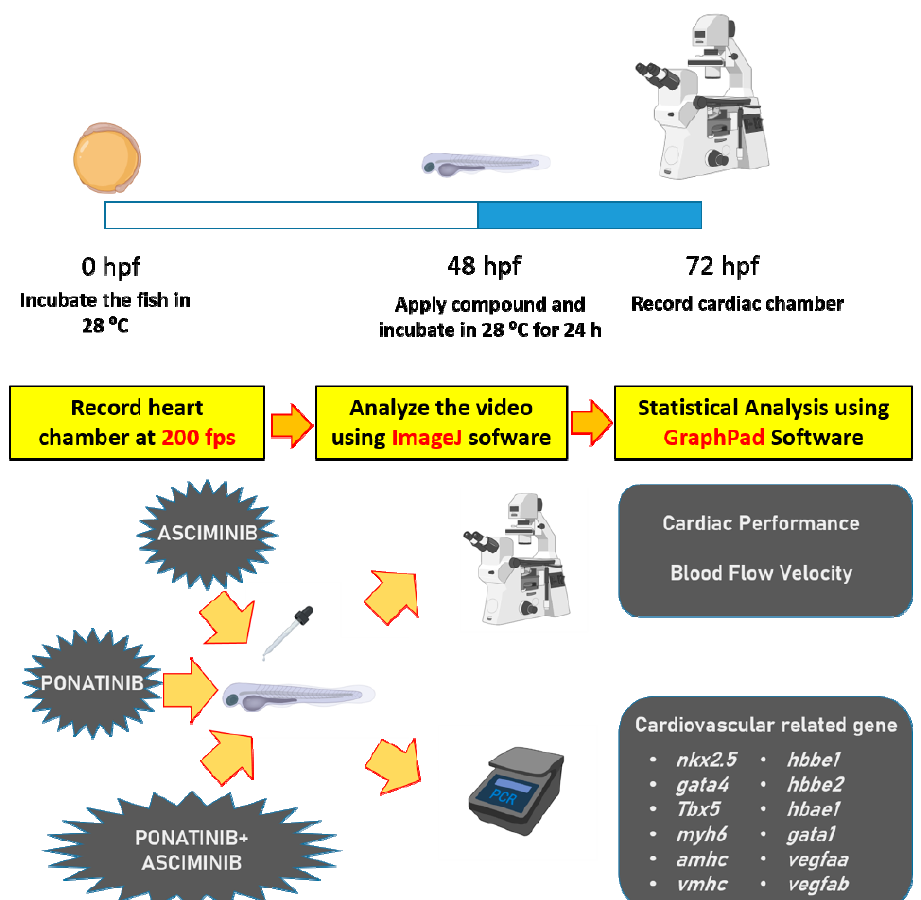
Figure 1. Schematic diagram showing the overall experimental design for the study. The upper panel shows the timing and workflow to conduct cardiovascular assessments in zebrafish. The bottom panel shows the physiological and molecular endpoints used to evaluate the potential adverse effect of the tested